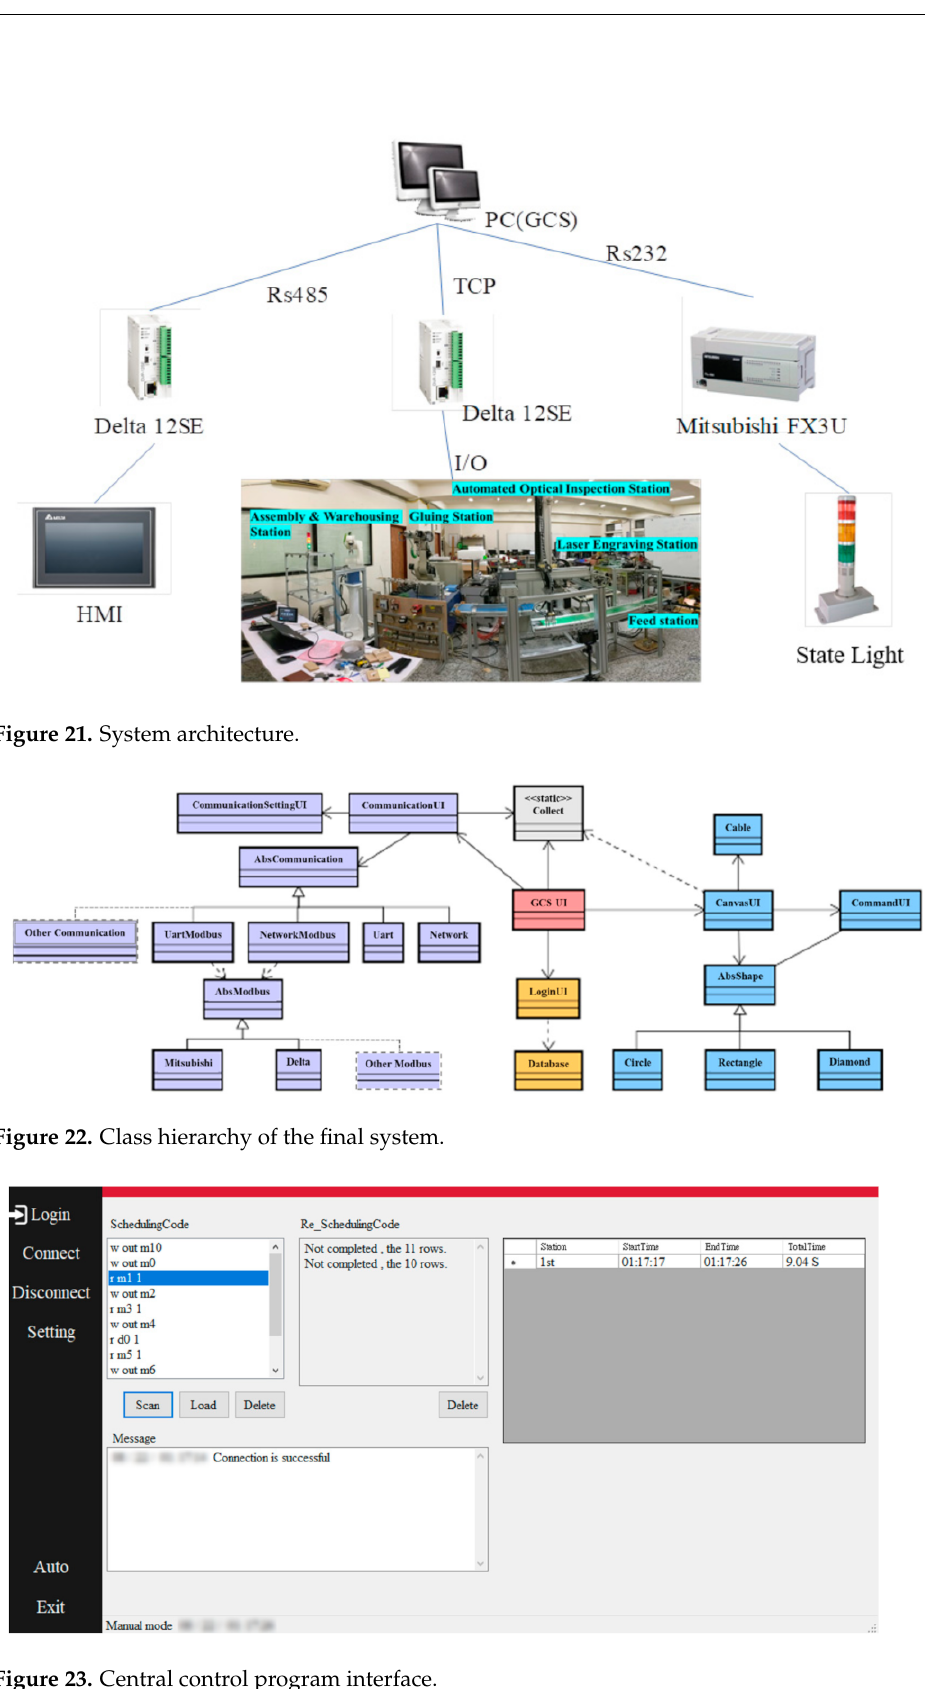
Figure 23. Central control program